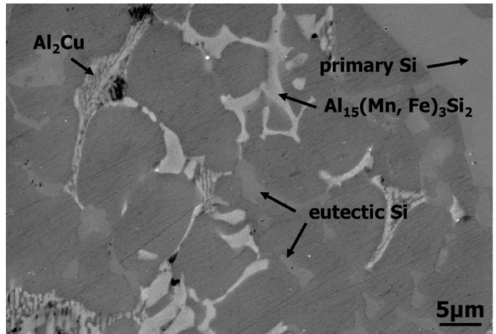
Figure 3. SEM image of the initial B390 showing intermetallic